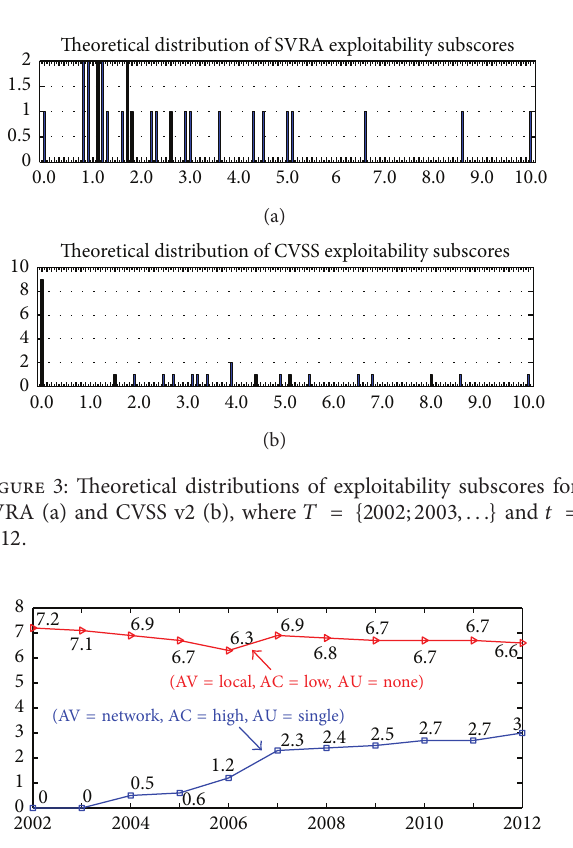
Figure 4: Exploitability subscore curves from 2002 to 2012 for two vulnerabilitytypes;theexploitabilityofavulnerabilitychangeswhen V (𝑡) increases over